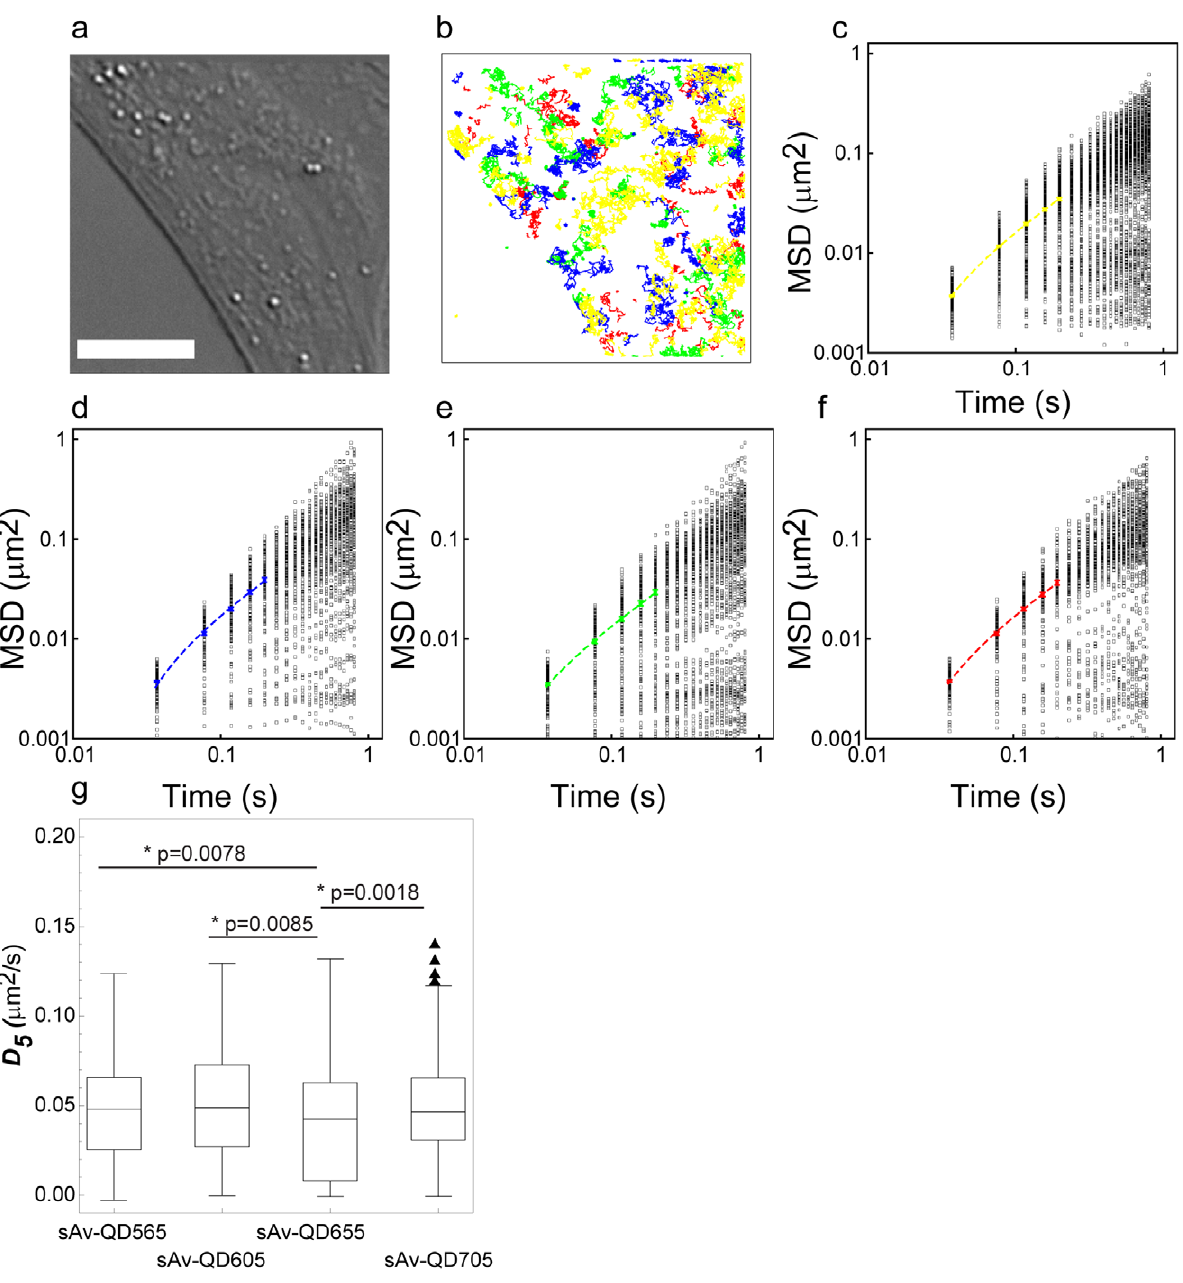
Figure 6. Four color MC-SPT of an artificially loaded lipid, biotin-cap-DPPE, in a live mouse embryo fibroblast (MEF). A synthetic lipid, biotin-cap-DPPE, was bulk loaded into the plasma membrane of live cells as described in the Methods section. Thus inserted lipids were subsequently labeled with a four color combination of sAv-QDs. (a) Differential interference contrast image of labeled cell. Scale bar equals 10 m m. (b) Superimposed single molecule trajectories for all trajectories, N, with, n . 20 image frames from SPT analysis showing the cumulative lateral motion of lipids during a 1200 image frame acquisition (acquired at an image acquisition rate of < 25 Hz for a time duration of < 48 s) that were labeled with sAv-QD565 (yellow, N=289), sAv-QD605 (blue, N=142), sAv-QD655 (green, N=162), and sAv-QD705 (red, N=131). The distributions of the number of QDs that were detected in each image frame are shown in Fig. S10. The distributions of trajectory lengths for each image channel are shown in Fig. S11. (c-f) Log 10 (MSD) versus log 10 (t) plots for all detected single molecule trajectories in (b) for the time intervals, t # n t # 20 t, in each separate QD color channel where (c) sAv-QD565, (d) sAv-QD605, (e) sAv-QD655, and (f) sAv-QD705. The MSD curves for each single trajectory were curve fit at short time intervals, , 40 # t # , 200 ms, to determine the diffusion coefficient, D 5 , as described in the Methods section. The distributions of the fitted values of